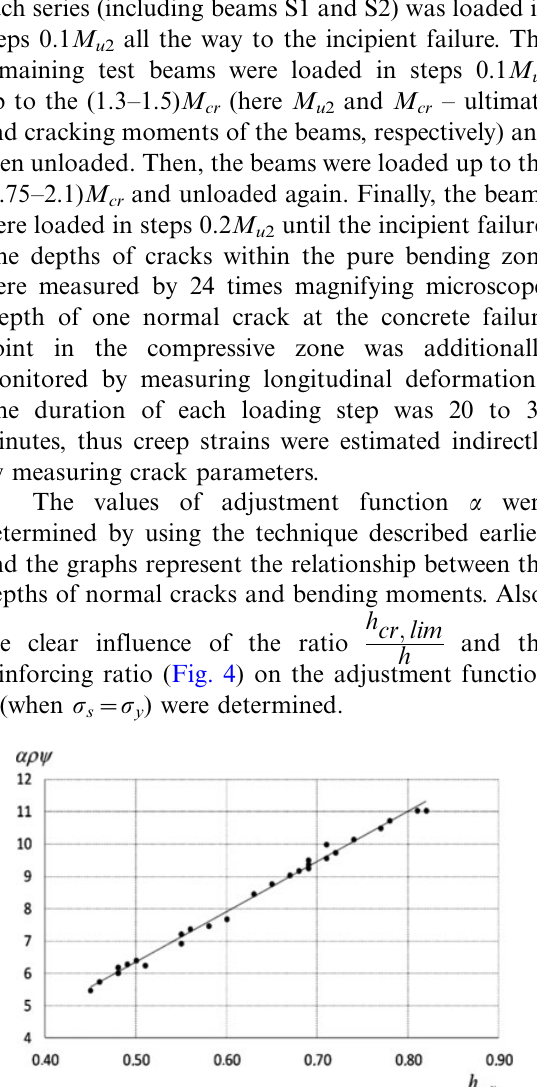
Characteristics of tensile reinforcement